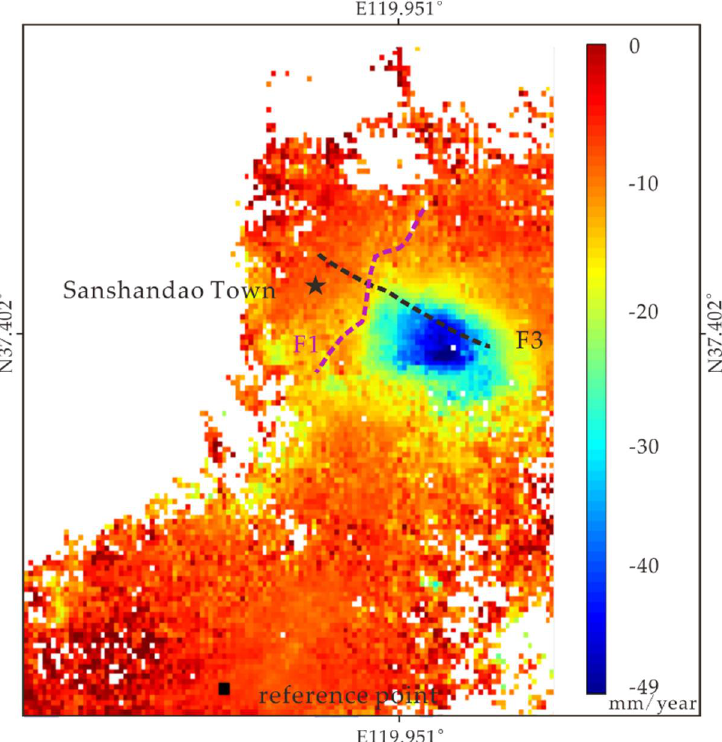
Figure 6 . The standard deviation of the mean LOS velocity estimation.